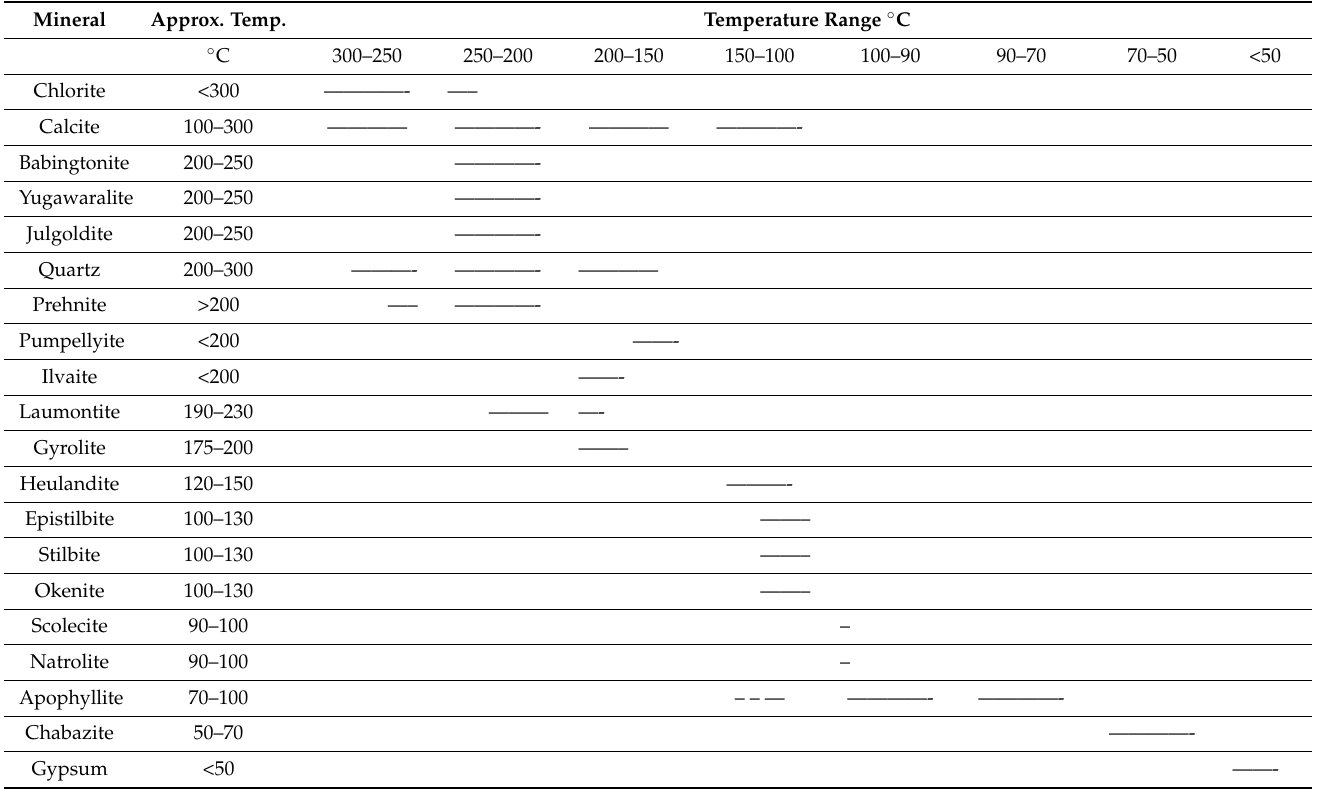
Table 6. Estimated formation temperatures of zeolites and associated minerals of Salsette